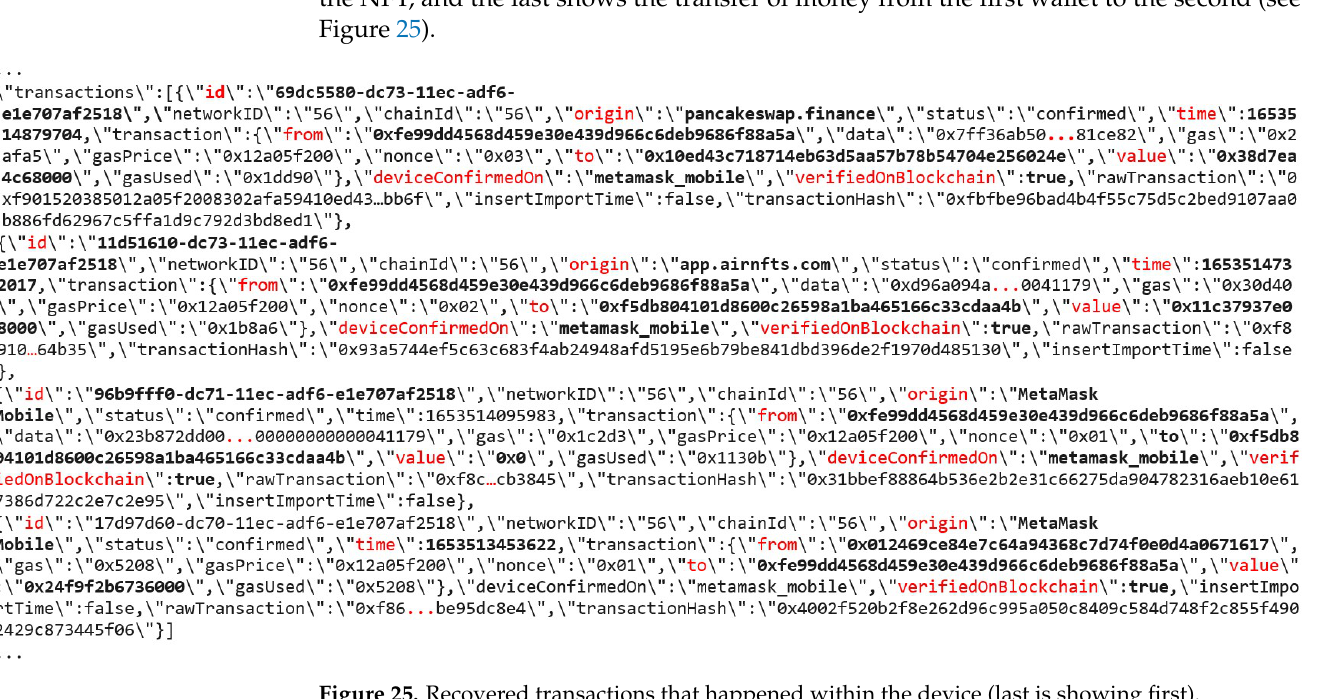
Figure 25. Recovered transactions that happened within the device (last is showing first).